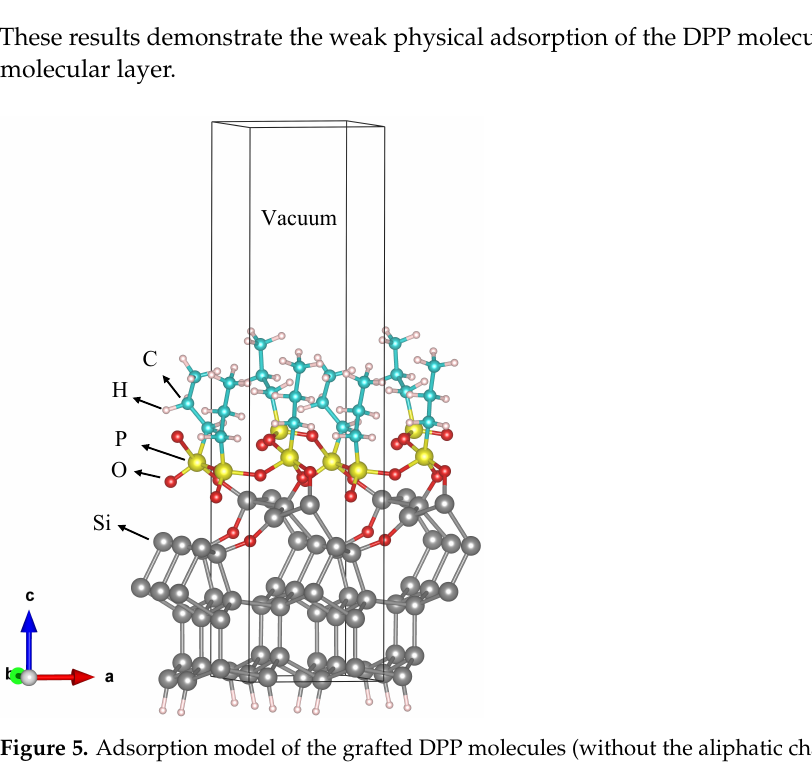
Figure 5. Adsorption model of the grafted DPP molecules (without the aliphatic chains) on a Si (111) 2 × 1 reconstructed surface after DFT geometry optimization.